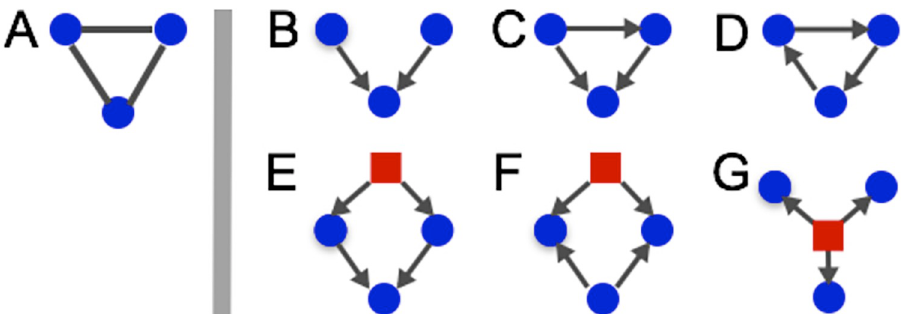
Fig 1. (A) The triangle structure connecting three genes in a Markov network. There are several possible directed (causal) structures that can explain these dependencies: (B) an unshielded collider, (C) a feed-forward loop, (D) a feedback loop, (E) cofactors that are both regulated by a common unmeasured variable, (F) a bi-fan in which one regulating factor is unmeasured, and (G) an unmeasured factor that regulates all three genes.